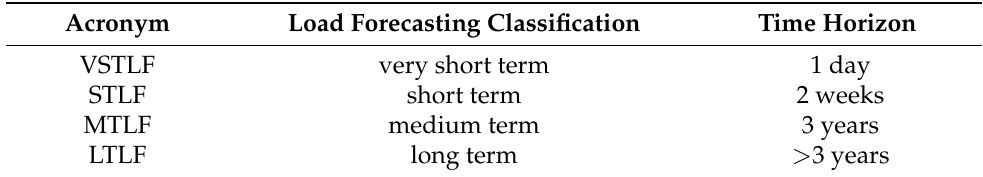
Table 1. Load forecast time term